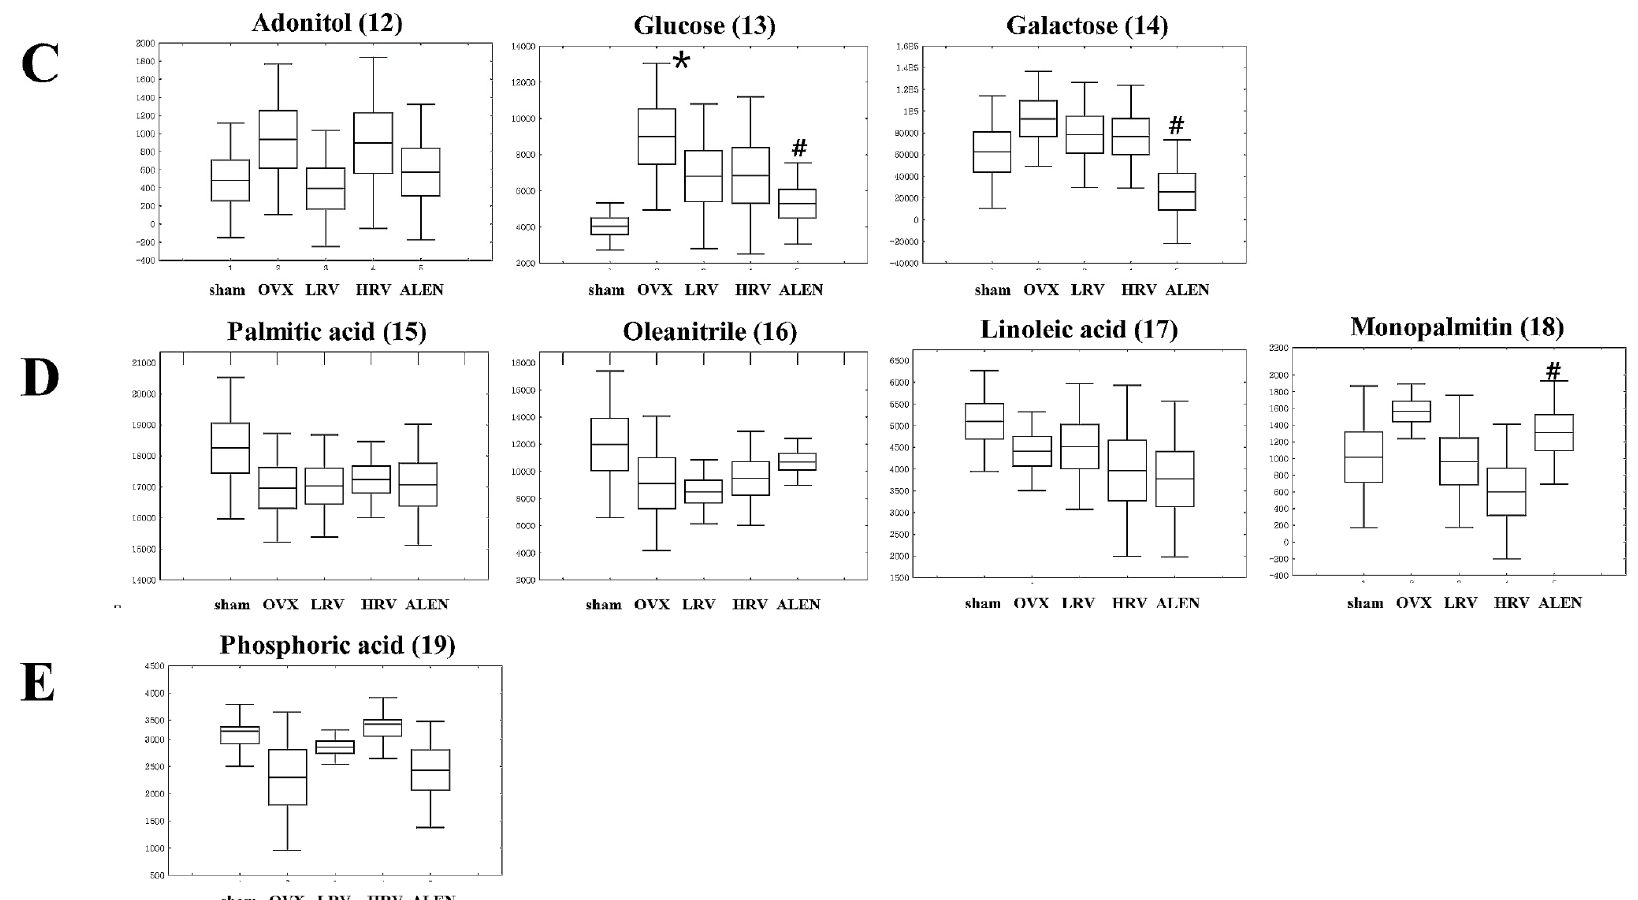
Figure 4. Box and whisker plot analyses of metabolites from GC-TOF-MS data among the five different rat groups. Amino acids ( A ); organic acids ( B ); sugars and sugar derivatives ( C ); fatty acids ( D ); and others ( E ). The numbers of the compounds in parentheses are the same as those referred to in Table 2. sham, sham-operated control; OVX, ovariectomized rat without treatment; LRV, ovariectomized rat treated with low-dose RC vinegar; HRV, ovariectomized rat treated with high-dose RC vinegar; ALEN, ovariectomized rat treated with alendronate. * p < 0.05 compared to the sham, # p < 0.05 compared to the OVX group.